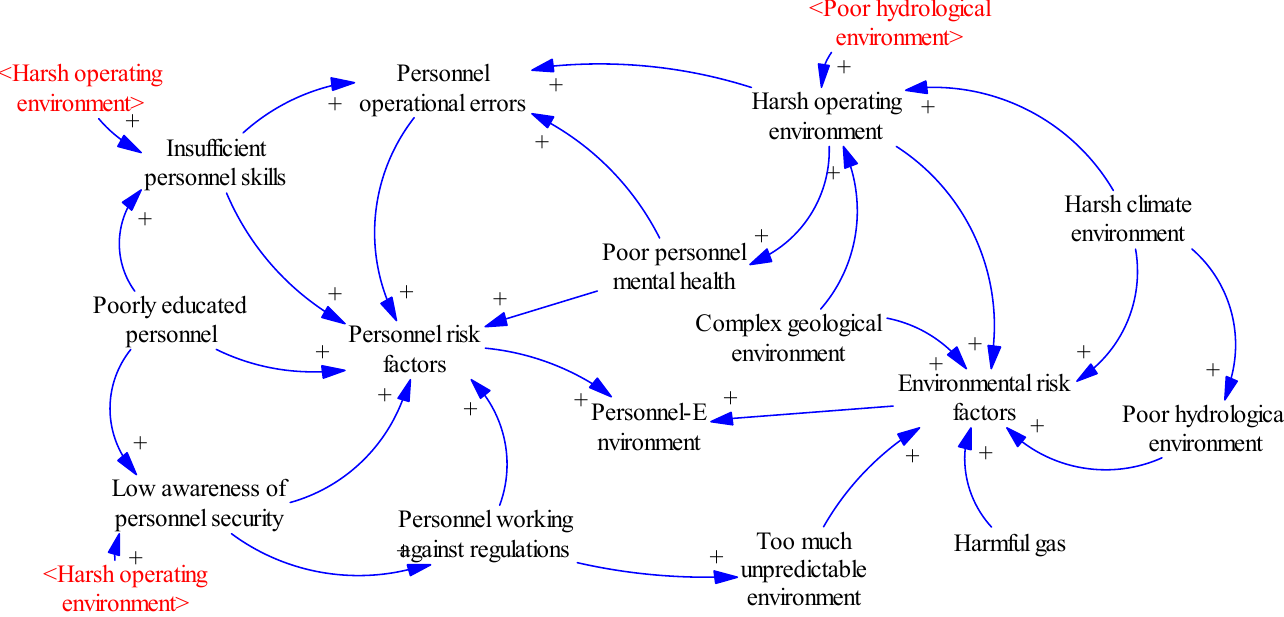
Figure 5. “Personnel–environment” coupling SD causality diagram.